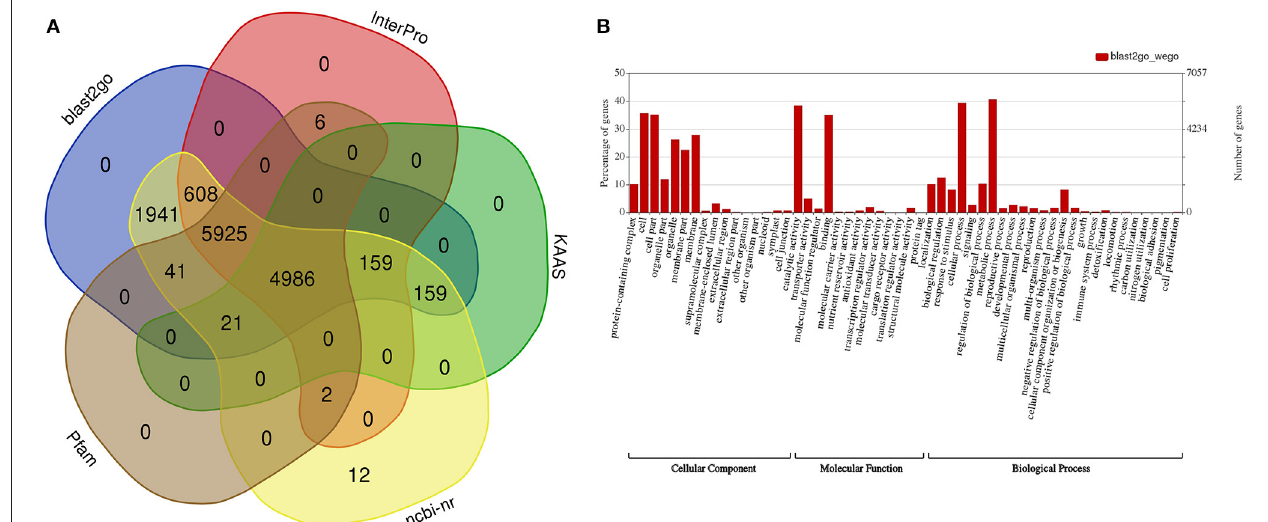
FIGURE 2 | Functional annotation of predicted genes in the draft guava genome assembly. (A) Number of genes functionally annotated in five public databases, (B) functional categorization of the annotated genes into cellular components, molecular function, and biological processes with WEGO.